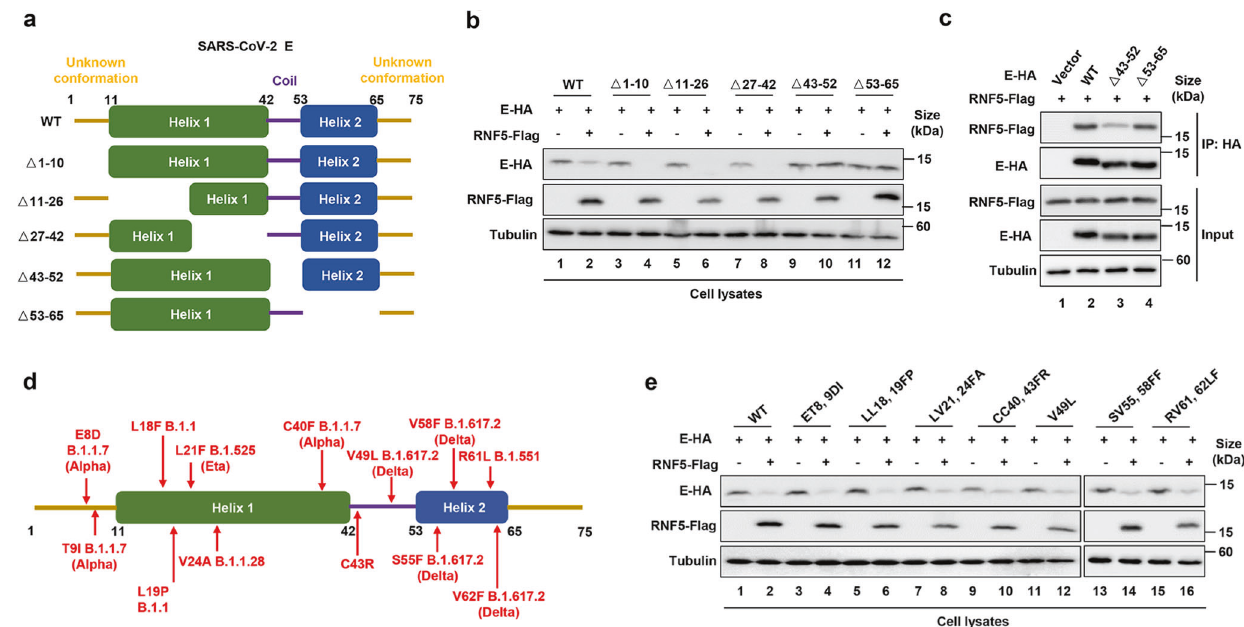
Fig. 6 The region of the E protein important for interacting with RNF5. a Schematic representation of E deletion mutants. b Sensitivity of E mutants to RNF5-mediated degradation. HEK293T cells transfected to express RNF5 and E-HA or its mutants were analyzed for protein levels by IB. c The E Δ 43 – 52 mutant has considerably lost the ability to bind RNF5. Binding between the E deletion mutants and RNF5 was determined by IP. d A schematic of E showing the positions of variations found in SARS-CoV-2 variants. e All tested E alleles from